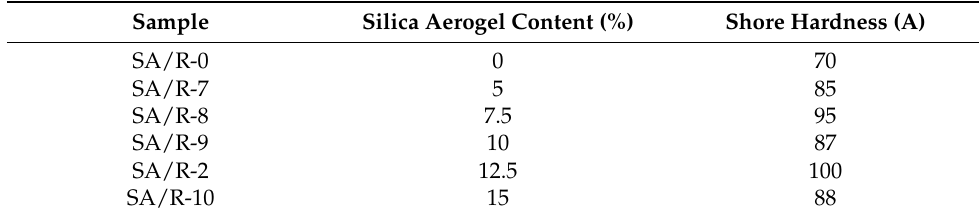
Table 2. Shore hardness of silica aerogel/resin composites.